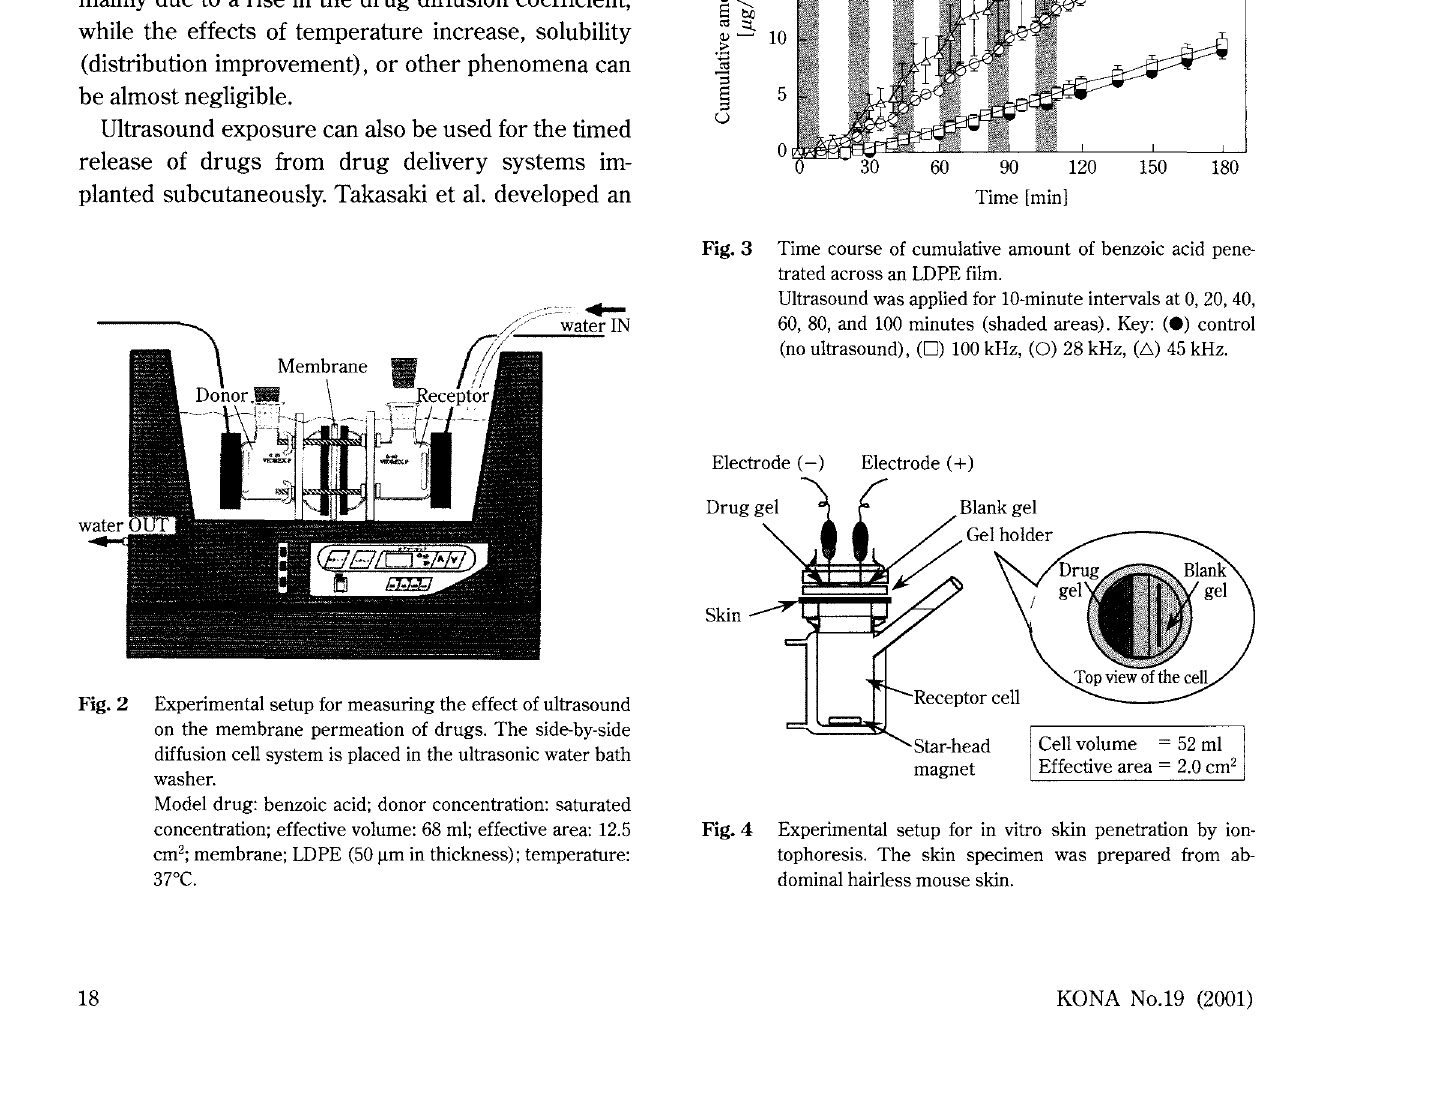
Cell volume = 52 ml Effective area = 2.0 cm 2 magnet Fig.4 Experimental setup for in vitro skin penetration by ion tophoresis. The skin specimen was prepared from ab dominal hairless mouse